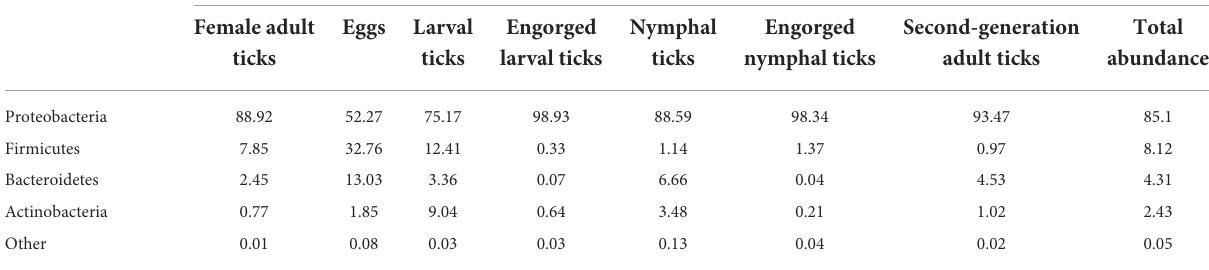
(20.63%), Pseudogracilibacillus (10.06%), Ornithobacterium (9.03%), and Coxiella (8.01%). Arsenophonus had the highest relative abundances of both larval ticks and engorged larval ticks (38.05 and 54.90%, respectively). The relative abundance of Rickettsia increased from 11.64% in the larval tick stage to 38.79% in the engorged larval tick stage. The relative abundance of Staphylococcus decreased from 9.65% in the larval tick stage to 0.18% in the engorged larval tick stage. Pseudomonas (27.76%), Brevundimonas (14.99%), Delftia (11.29%), and Stenotrophomonas (8.27%) were the genera with higher relative abundances among the nymphal ticks. The dominant genera in the engorged nymph stage were Arsenophonus (64.94%) and Rickettsia (29.07%). In the second generation of adult ticks, the genus with the highest relative abundance was